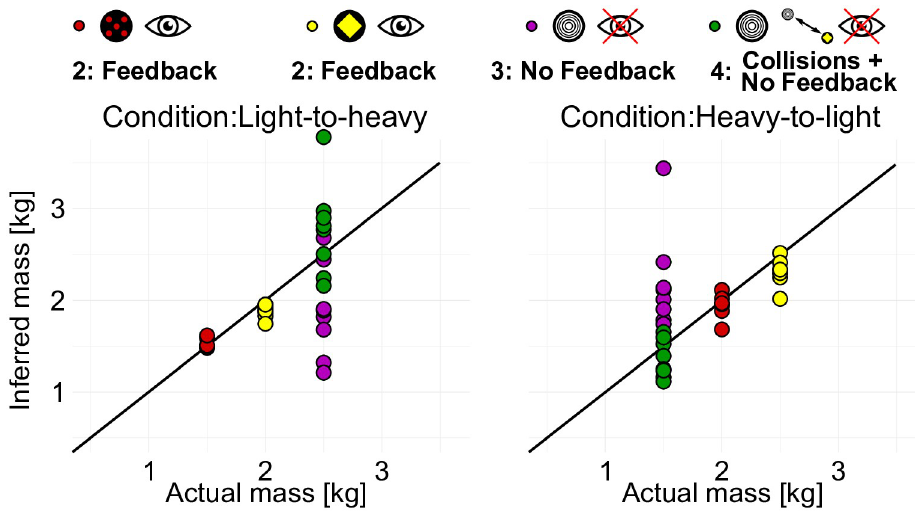
Fig 8. MAP values of inferred latent mass in Newtonian model class with quadratic loss function for each participant and condition.